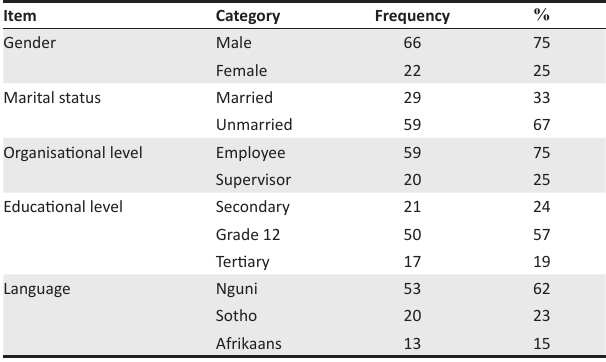
TABLE 1: Characteristics of participants.